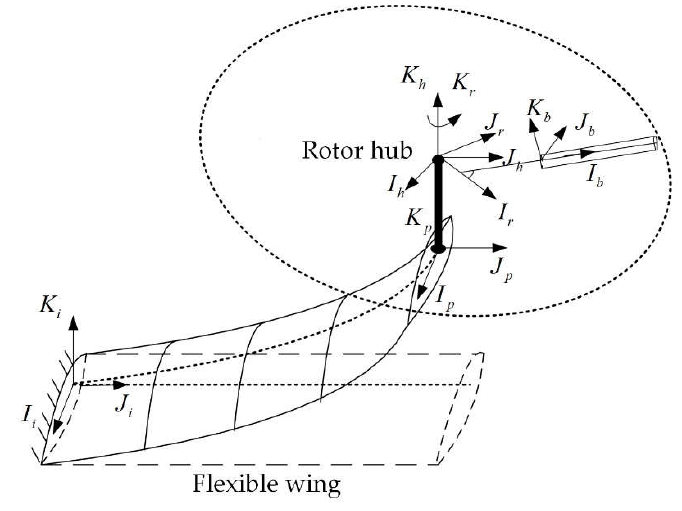
Figure 1. Flexible wing and coordinate systems defined on the rotor.